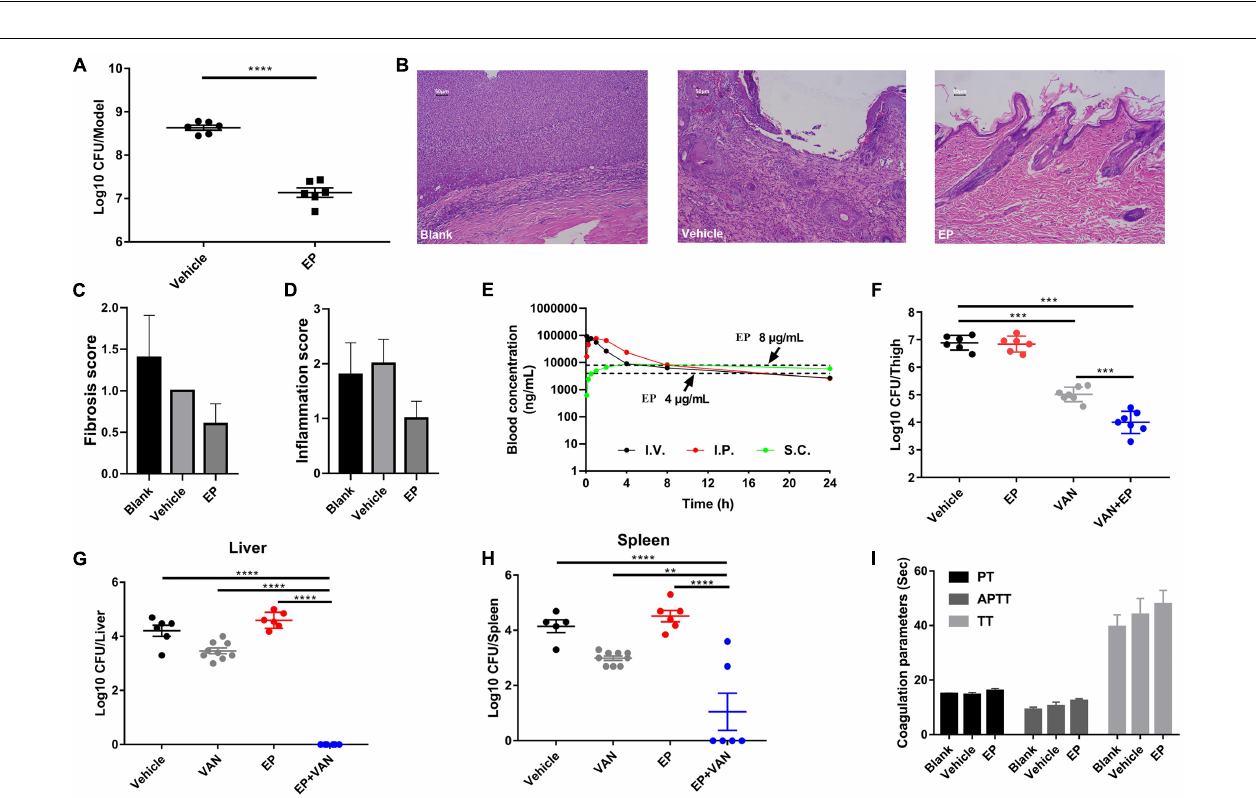
FIGURE 6 | In vivo efficacy of EP in mouse infection models. (A) Acute skin infection model. Each group of S. aureus USA300-infected BABL/C mice was treated with 2% (w/v) EP or vehicle (ointment) every 5 h for a total of 24 h. The infected skin tissues were excised and homogenized 5 h after the last treatment dose and subjected to CFU counting. (B) H&E staining of New Zealand rabbit skin after treatment with EP or vehicle (ointment) for 7 days. The backs of adult New Zealand rabbits were shaved with a razor and scratched with an abrasive paper to form a wound measuring 2 cm × 2 cm. Each group was treated with EP (2%, w/v), blank (saline), or vehicle (ointment) every 5 h on the first day and every 12 h in the succeeding days. On the last day of treatment, the infected skin tissues were excised and stained with H&E. (C) Fibrosis and (D) inflammation scores of the skin tissues were measured by H&E staining. (E) Pharmacokinetic curves of EP (30 mg/kg) administered via i.v., i.p., and s.c. injection. Dotted lines indicate the concentrations of EP that reached the minimal inhibitory concentration (MICs) (4 and 8 µ g/mL) in serum. (F) Antimicrobial activity of EP alone or in combination with VAN in a deep-thigh mouse infection model. Six to seven neutropenic ICR mice (biologically independent animals) per group were treated with 30 mg/kg of EP (i.p.) alone or in combination with 30 mg/kg of VAN (i.p.) or vehicle (5% Kolliphor + 5% ethanol, i.p.). EP and VAN were administered at intervals of 12 h and 5 h, respectively, for a total of 24 h. After the last treatment dose, the infected thigh tissues were excised and homogenized and subjected to CFU counting. (G,H) Effect of EP alone or in combination with VAN on microbial burden in liver and spleen in a mouse model of intra-abdominal infection. Mice were infected with 0.5 mL of the indicated inoculum of S. aureus USA300 (i.p.) and 5% (w/v) mucin. Each group was treated with 30 mg/kg of VAN (i.p.) alone or in combination with 30 mg/kg of EP (i.p.) at intervals of 5 h and 12 h, respectively, for a total of 24 h. After the last dose, the microbial burden in the liver and spleen was assessed by CFU counting. (I) Plasma coagulation parameters (PT, APTT, and TT) of the rats after treatment with 30 mg/kg of